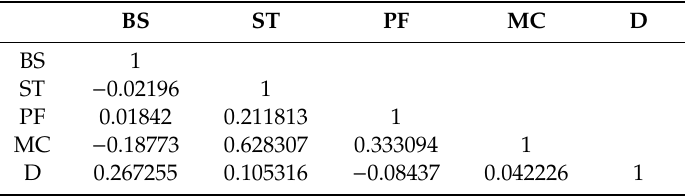
Table 5. Correlation coefficient of model inputs.